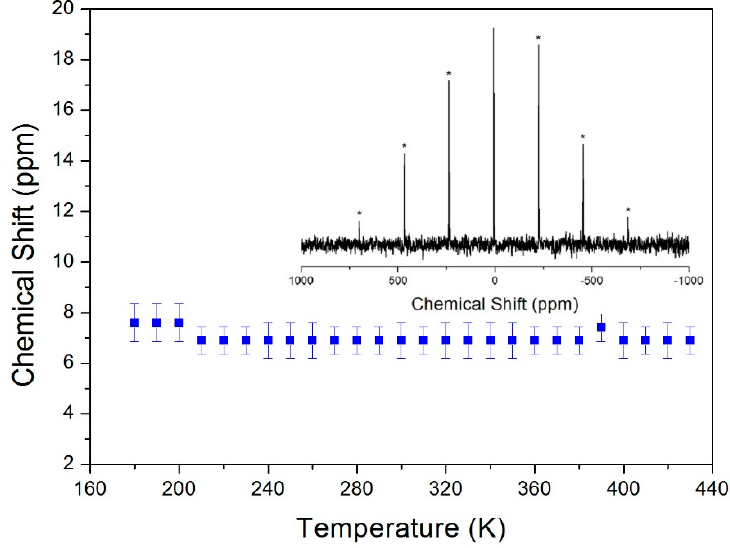
Chemical shift in 14 N MAS NMR spectra in (C 3 H 7 NH 3 ) 2 CdCl 4 vs. temperature. Inset: Spectrum at 300 K, and the spinning sidebands are marked with asterisks.